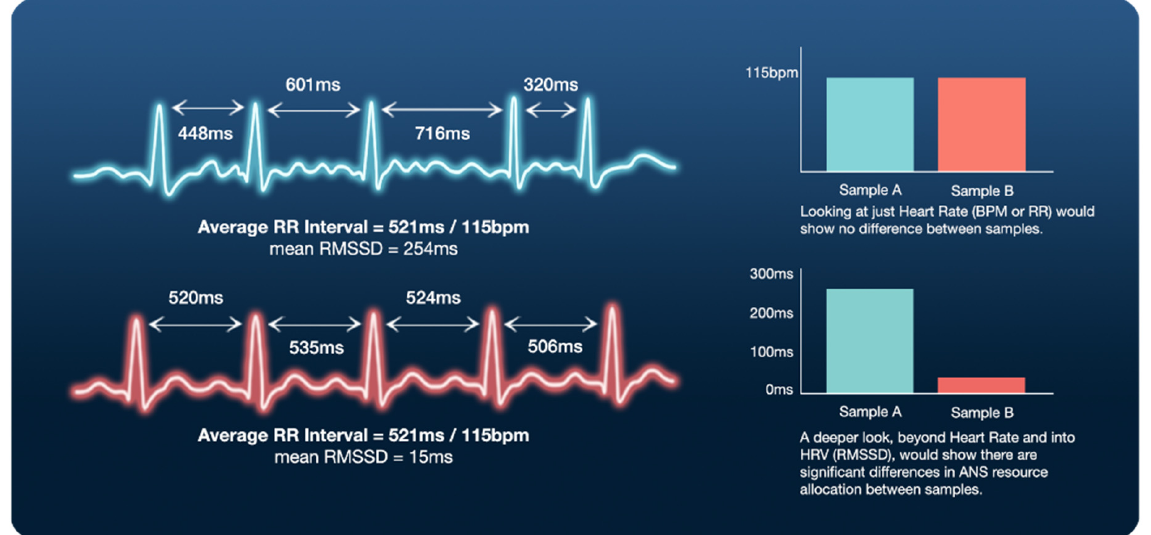
Figure 2. Example of R-R intervals in milliseconds (duration between R peaks from consecutive QRS complexes). Trace 2 (lower, in red) shows little/negligible heart rate variability (HRV). Trace 1 (upper, in blue) shows significant HRV. Data table on right exemplifies importance: average heart rate (HR as bpm) is identical, but when the underlying signal is teased apart, massive differences in root mean squared of successive differences (RMSSD ~ 17 fold) and can be used to infer significant differences in autonomic nervous system (ANS) resource allocation between the same samples.